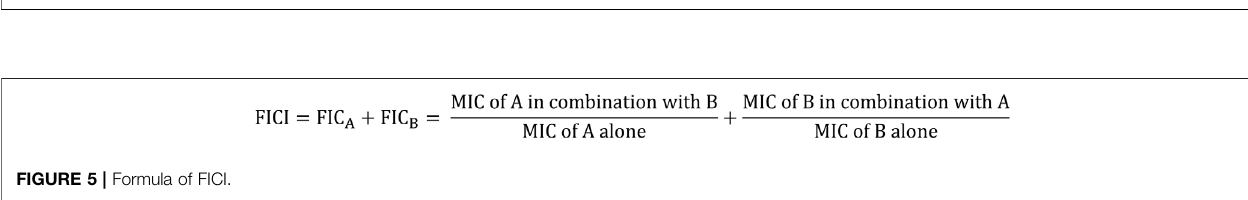
FIGURE 5 | Formula of FICI.